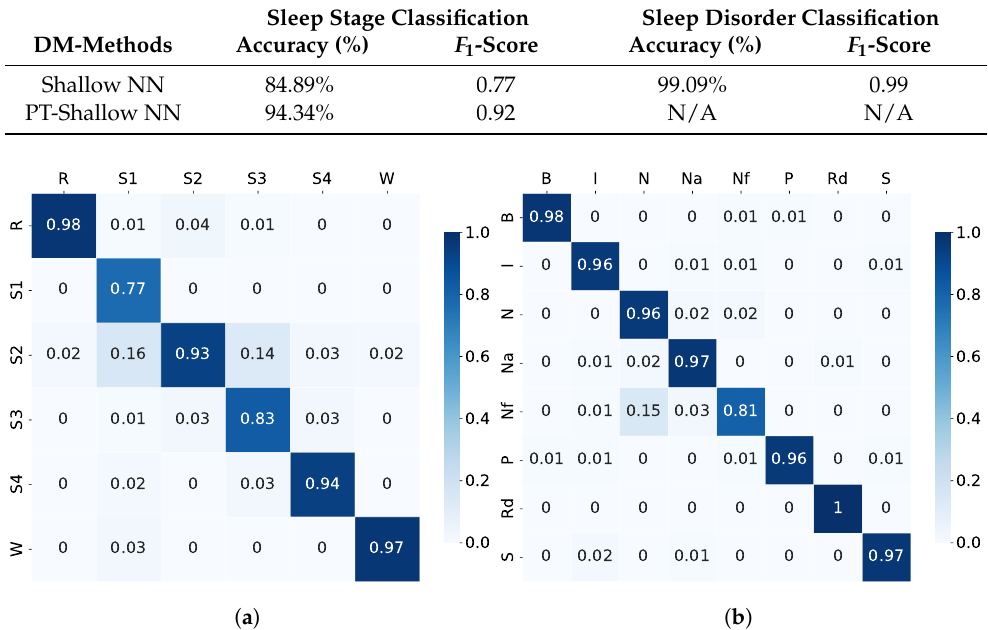
Table 6. Experiment 3: Classification results for MML-DMS2 using a shallow decision-making NN (PT-Shallow NN: pre-trained NN; Shallow NN: trained-from-scratch NN).